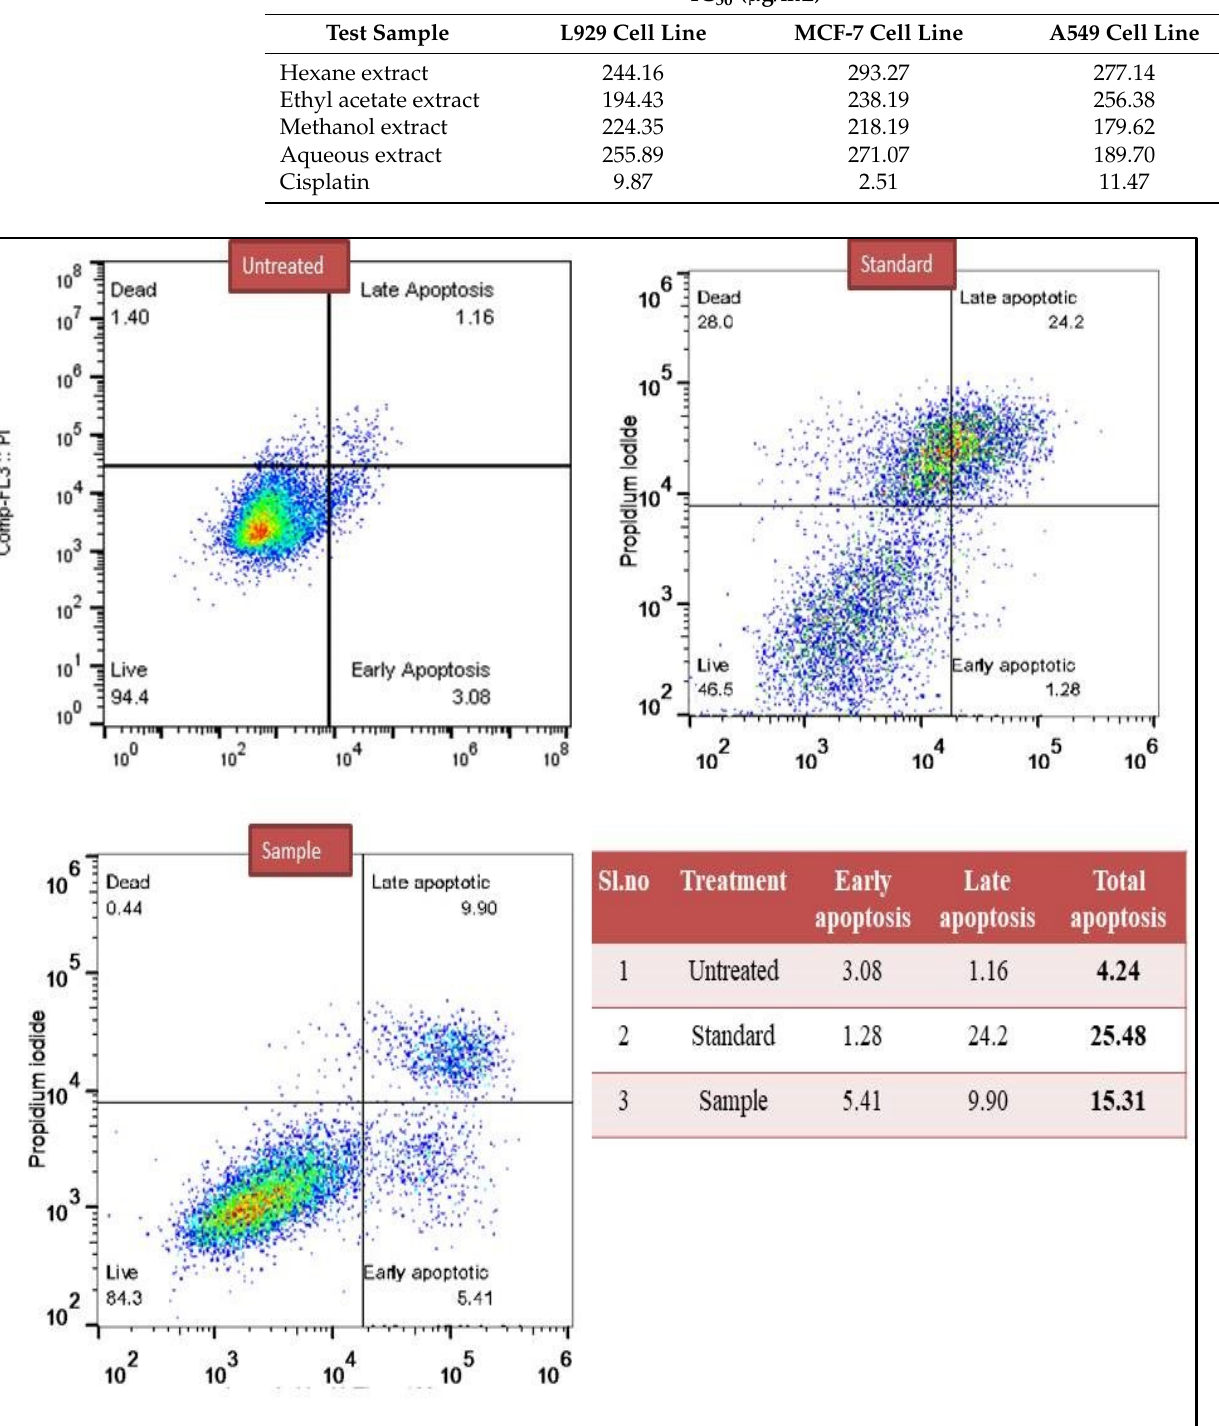
Figure 1. Detection of early and late apoptosis induced by methanol extract of T. terrestris in the MCF-7 cell line. Green and orange red colour is due to cells reaction with dyes used in the flowcytometry, whereas the blue colour indicates the cells going through apoptosis death which are positively stained with Annexin V.